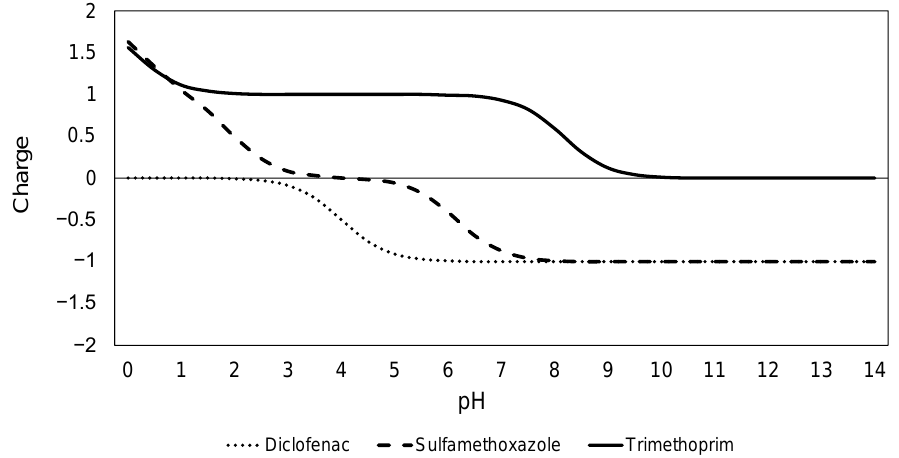
Figure 3. Changes in the ionization state of DCF, SMX and TMP as a function of the pH. J Chem for Office (20.11.0, ChemAxon, https://www.chemaxon.com, accessed on 11 June 2021) was used for calculating the ionization state.